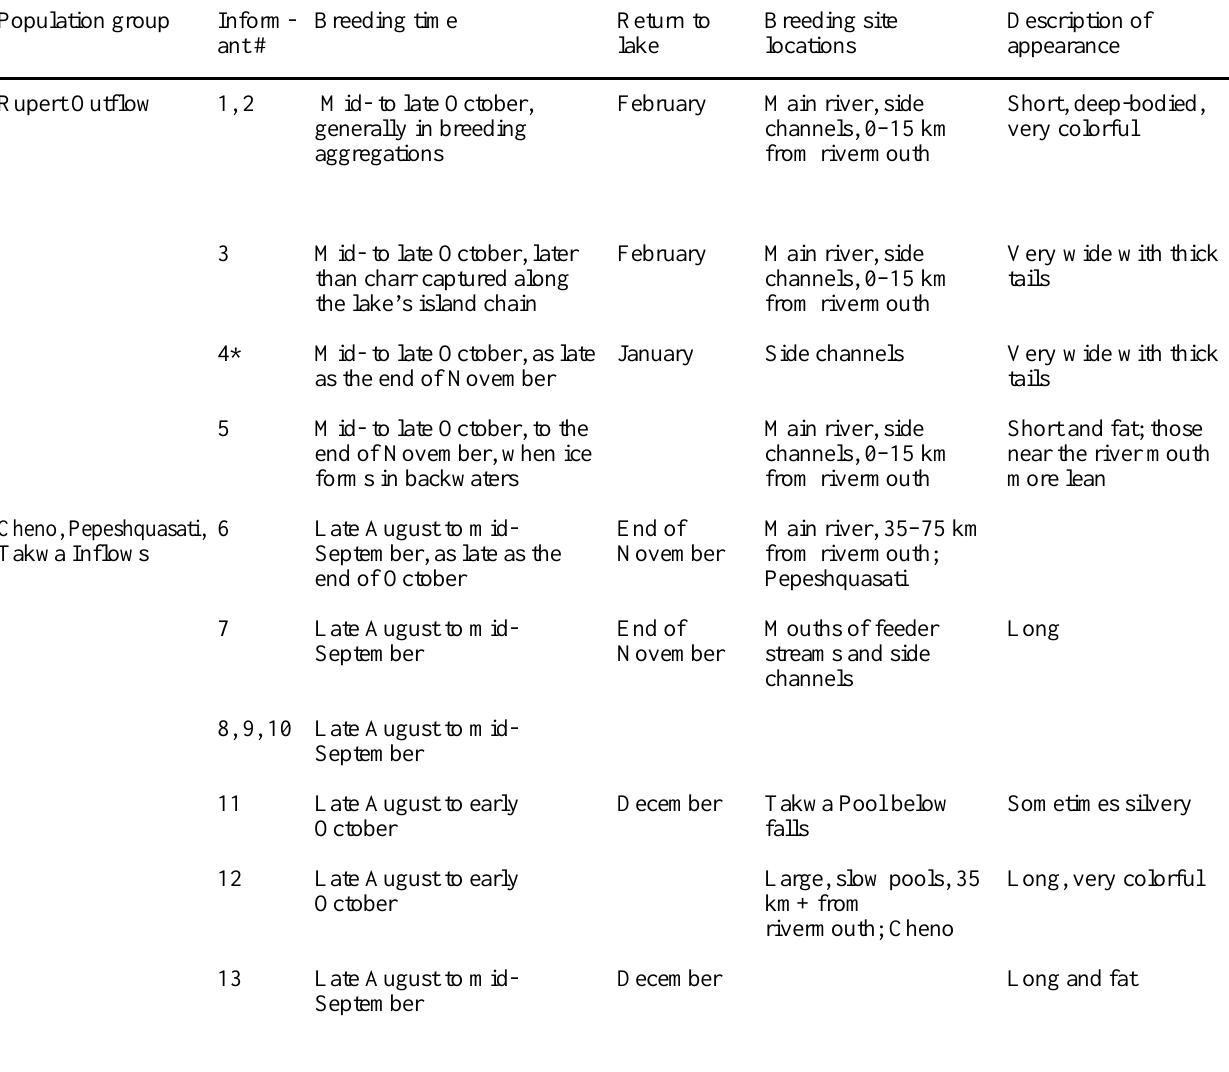
Table 3. Summary of traditional ecological knowledge (TEK) for breeding area characteristics of brook charr reported by local experts of the community of Mistissini. When information was unavailable from particular experts, blank spaces are used. #, each informant. Asterisks denote where community fishers and/or fishing guides made similar